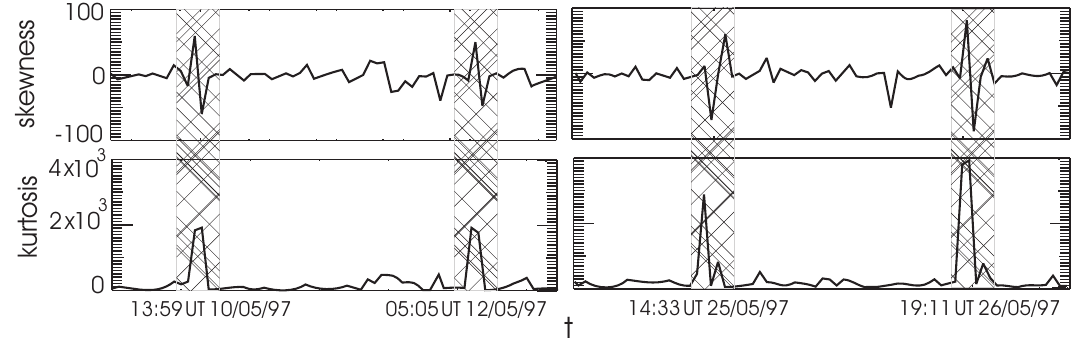
Fig. 6. Illustration of 4 EIT waves and dimming signatures in May 1997. The upper panel plots the skewness (or asymmetry) of the difference images versus time; the lower panel shows the kurtosis (sharpness of the peak). Moments are constructed for the distribution of the intensity difference of subsequent images.